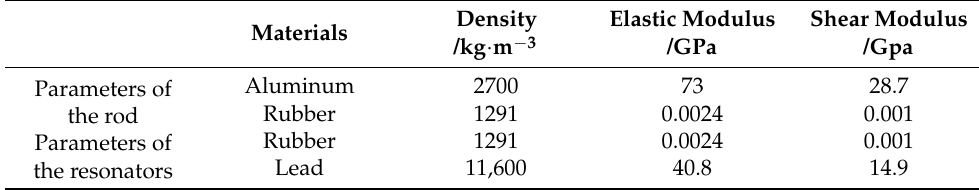
Table 1. Properties of materials.